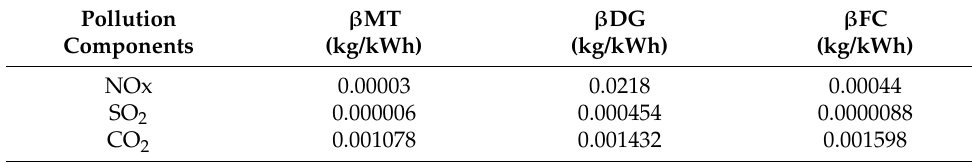
Table 7. Pollution components and emission factors of pollution [30].